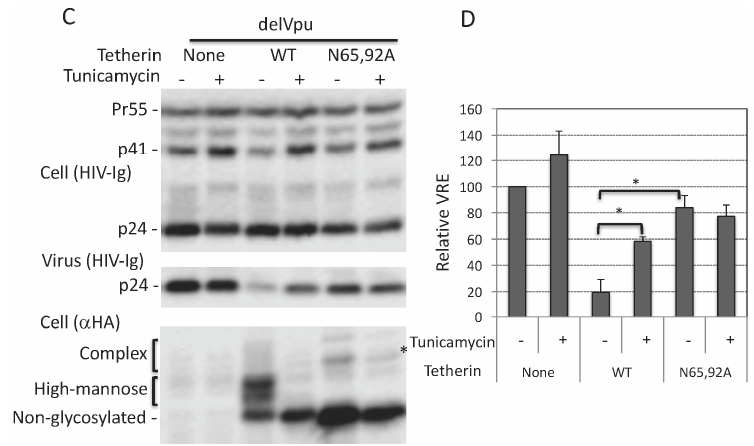
Figure 1. Glycosylation of at least one Asn is required for tetherin antiviral activity. ( A ) 293T cells were transfected with wild-type (WT) or Vpu-defective (delVpu or Udel) pNL4-3 HIV-1 molecular clones, and vectors expressing hemagglutinin (HA)-tagged WT or glycosylation-defective tetherin mutants (N65A, N92A, and N65,92A). One day post transfection, cell and viral lysates were prepared and subjected to western blot analysis with HIV-Ig to detect the Gag precursor Pr55Gag (Pr55) and the capsid (CA) protein p24, anti-HA to detect HA-tagged tetherin or anti-Vpu antisera. The location of non-glycosylated, high-mannose and complex-glycosylated tetherin species is indicated. “}” indicates the position of complex-glycosylated tetherin; ( B ) virus release efficiency (VRE) was calculated as the amount of virion-associated p24 (CA) relative to total Gag in cell and virus. VRE was set to 100% for WT HIV-1 in the absence of tetherin; ( C ) 293T cells were transfected with the delVpu HIV-1 molecular clone with or without HA-tagged WT or N65,92A tetherin expression vector. Eight hours post transfection, cells were untreated or treated with 1 μ g/mL tunicamycin for one day, and cell and viral lysates were collected as in Figure 1A. * denotes putative dimeric tetherin; ( D ) VRE was calculated as in Figure 1B; VRE for no tetherin and untreated controls was set to 100%; ( B , D ) Data shown are ± standard deviation (SD) from three independent experiments. p values (two-tailed paired t -test): * p < 0.001.